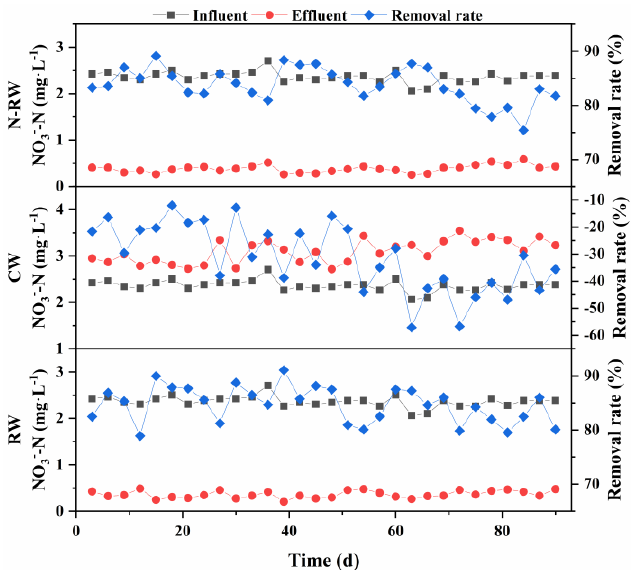
Figure 3. Changes of NO 3 − -N concentration and corresponding removal rate in influent and effluent of three groups of wetland systems.